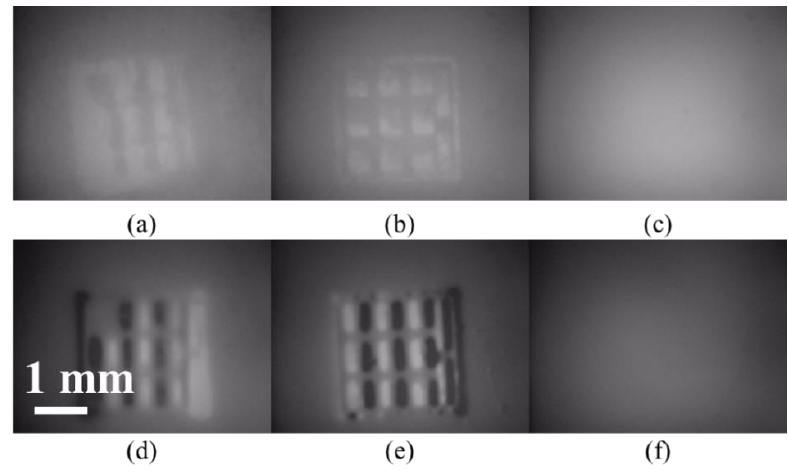
Figure 7. ( a – c ) Off-plane magnetic field to nickel, iron and gold tags, respectively. ( d – f ) In-plane magnetic field to nickel, iron and gold tags, respectively. Gold tag has a small magnetization and tag identification is difficult, but the conditions of ( d , e ) are the most suitable for tag identification.